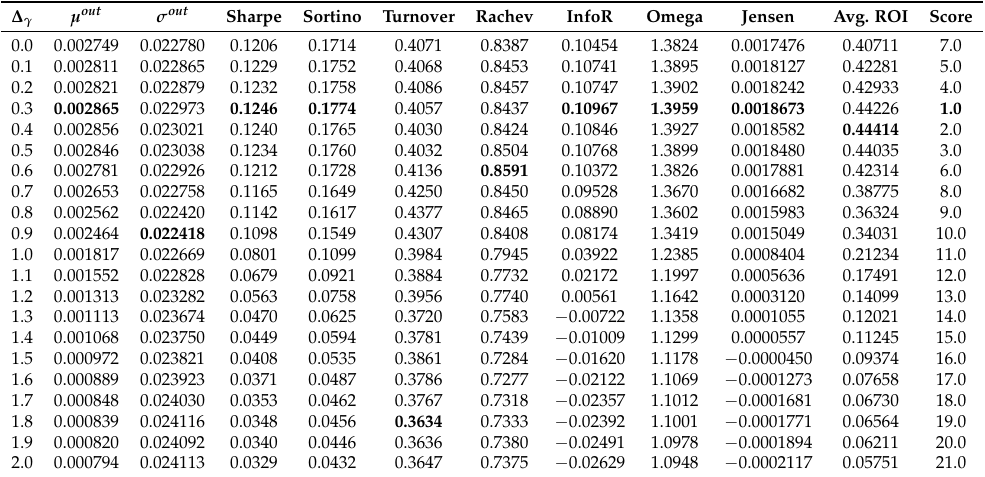
Table 11. ETF: out-of-sample performance results for the RMZ R strategy by varying ∆ γ , where ∆ γ is the skewness parameter and score is the median value of the overall performance rankings. The best results are marked in bold.